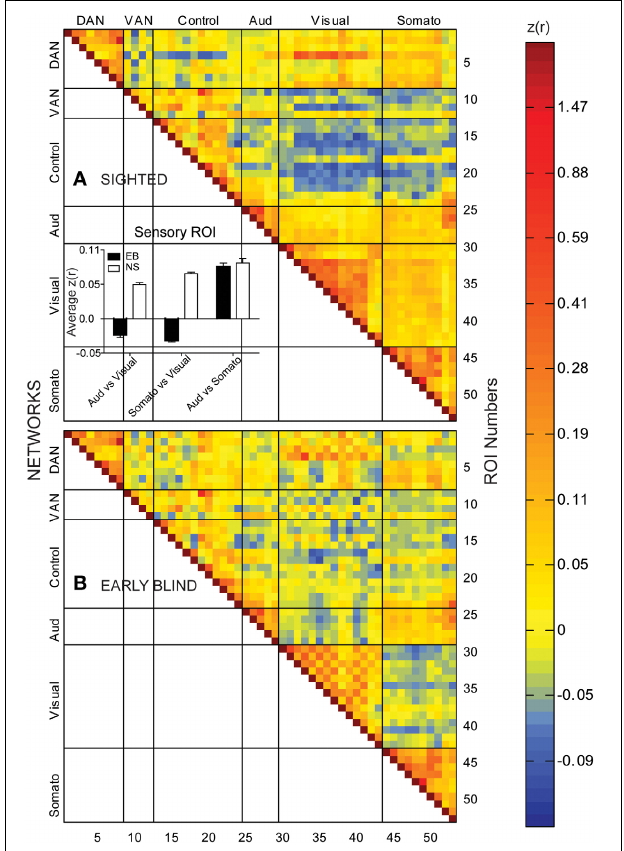
FIGURE 2 | Matrix of significant group differences in temporal correlation coefficients (A). Seed pairs correspond to ROI Numbers listed in Table 2 . Filled cells indicate p -values of t- tests. (B) Bar graphs of mean and standard errors for temporal correlation coefficients in each